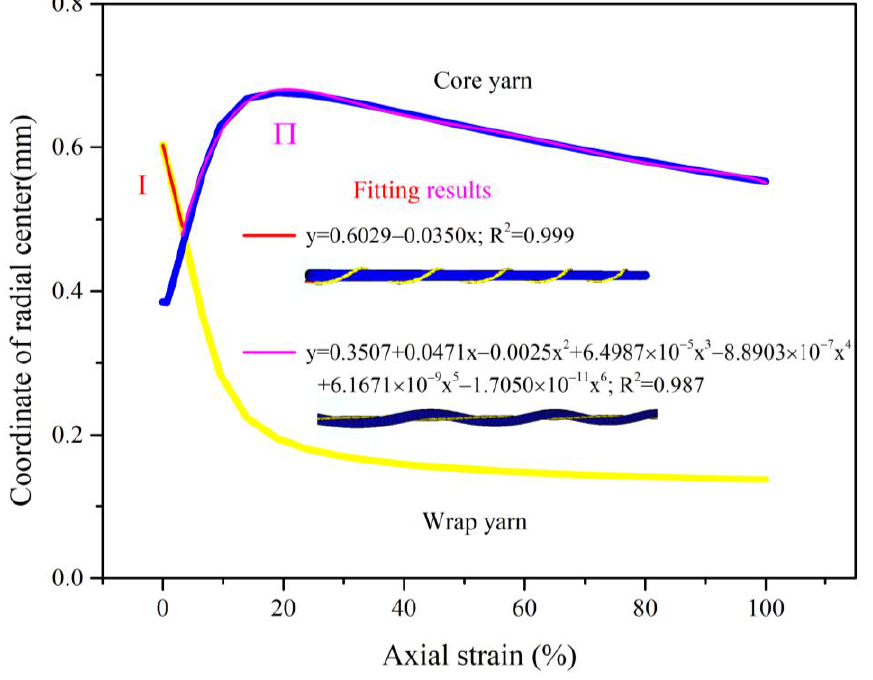
Figure 9. Radial center of auxetic yarn under axial strain.